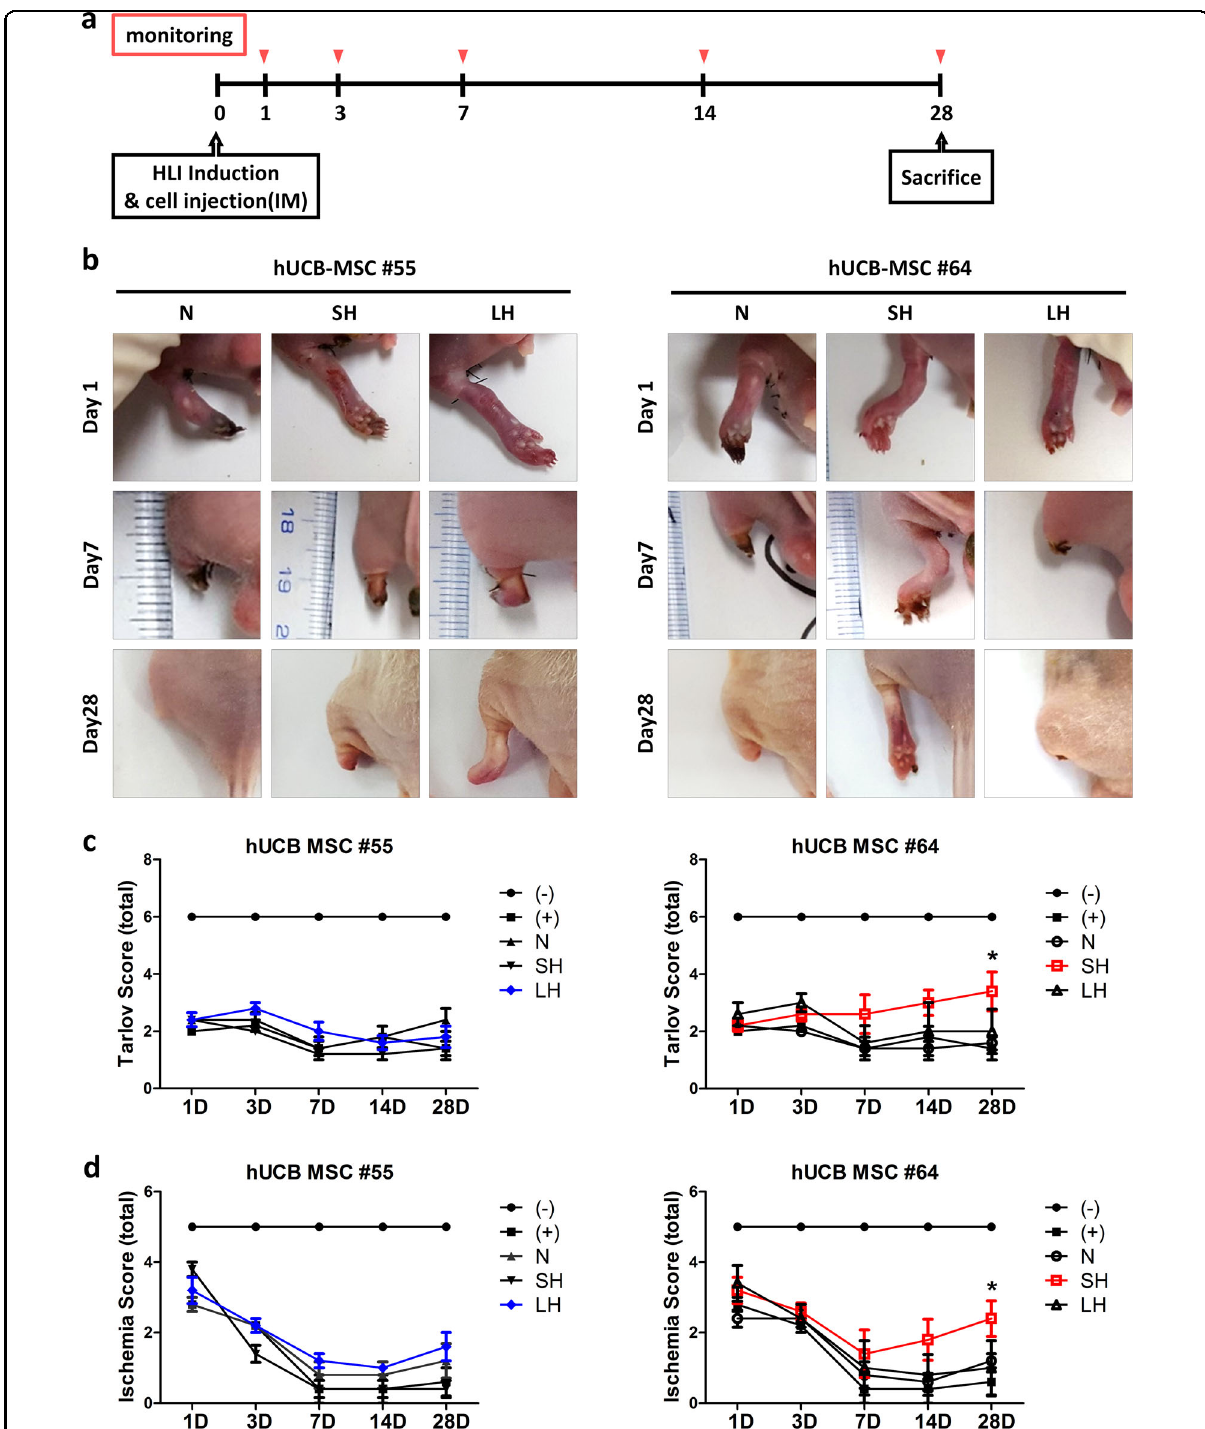
Fig. 2 Therapeutic effect of normoxic- and hypoxic-preconditioned hUCB-MSCs in a hindlimb ischemia animal model. Hindlimb ischemia was induced by ligations on the femoral artery and collateral vein. On Day 0, the hUCB-MSCs derived from different donors were injected after normoxic, short term and long term of hypoxic conditioning. a Scheme of HLI induction and cell treatment. b The HLI-induced mice were monitored on Days 1, 3, 7, 14, and 28, and photographic images of ischemic lesions were collected for gross examination. Functional recovery of cell-injected HLI mice was quanti fi ed by the ( c ) Tarlov and ( d ) Ischemia score systems. The results separately show the data from cell-injected groups for better legibility. In vivo experiments conducted under the same experimental conditions and whole-data of photographic images and functional quanti fi cations, including negative and positive control groups are shown in Supplementary Figure S2. Five mice/group were used. * P < 0.05. Results are shown as the mean±